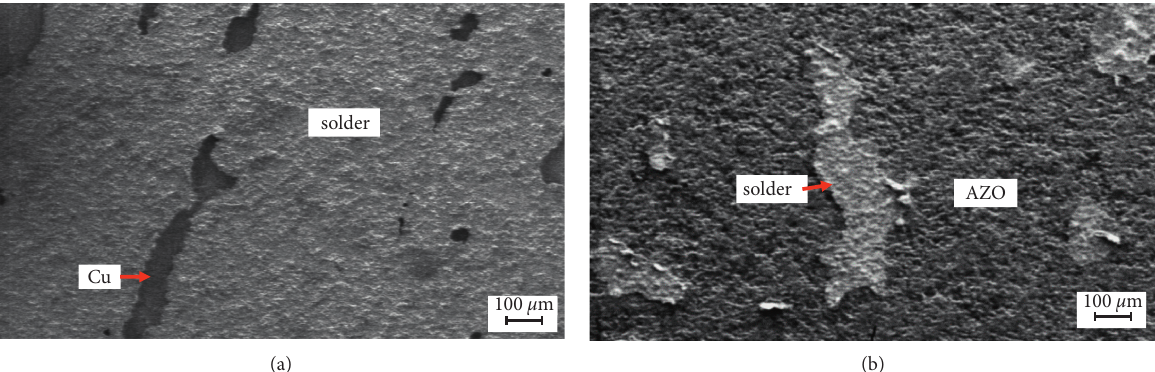
Figure 7: Fractography of an AZO/Cu joint with Sn AZO side.